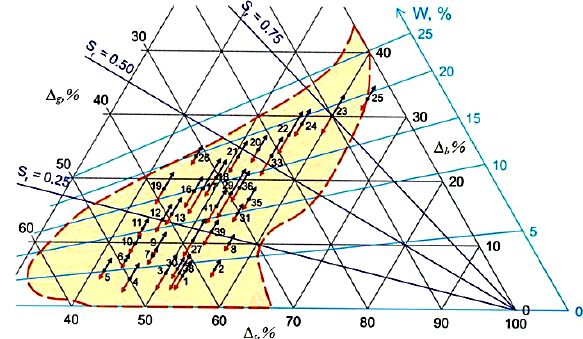
Fig. 7. Dynamics of sand gravimetric moisture content change at thermal moisture transfer after 20 h: points are the initial values of humidity before thermal moisture transfer, the figures near the points are numbers of experiments, the arrows are vectors of final moisture formed after thermal moisture transfer at “cold” (arrow pointing up) and “hot” (arrow pointing down) butt ends of the samples